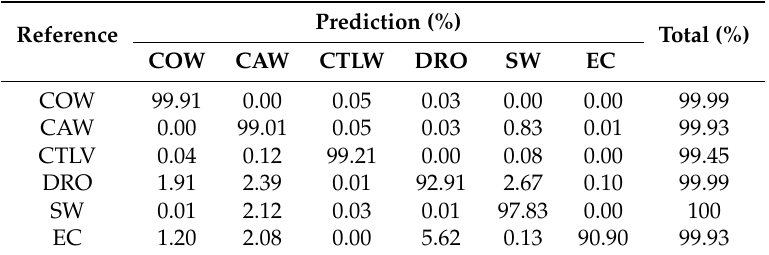
Table 5. Confusion matrix of partial classes in the bidirectional mode. Values denote the point proportion of the